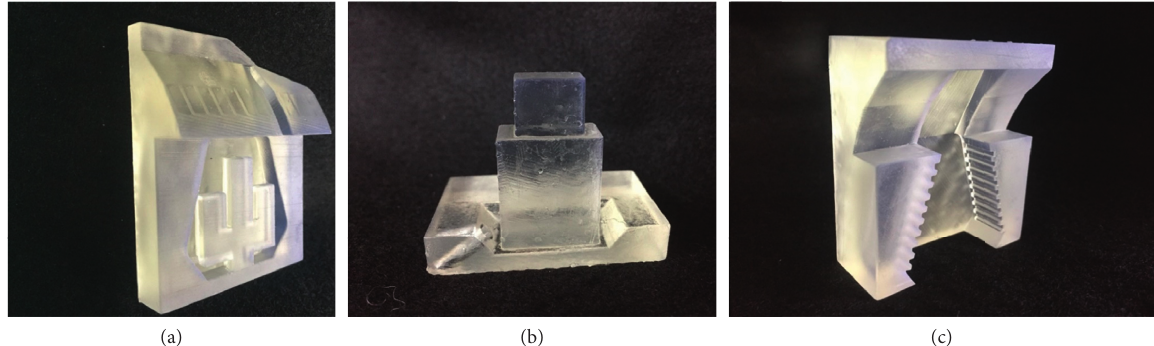
Figure 17: 3D printing finished product.